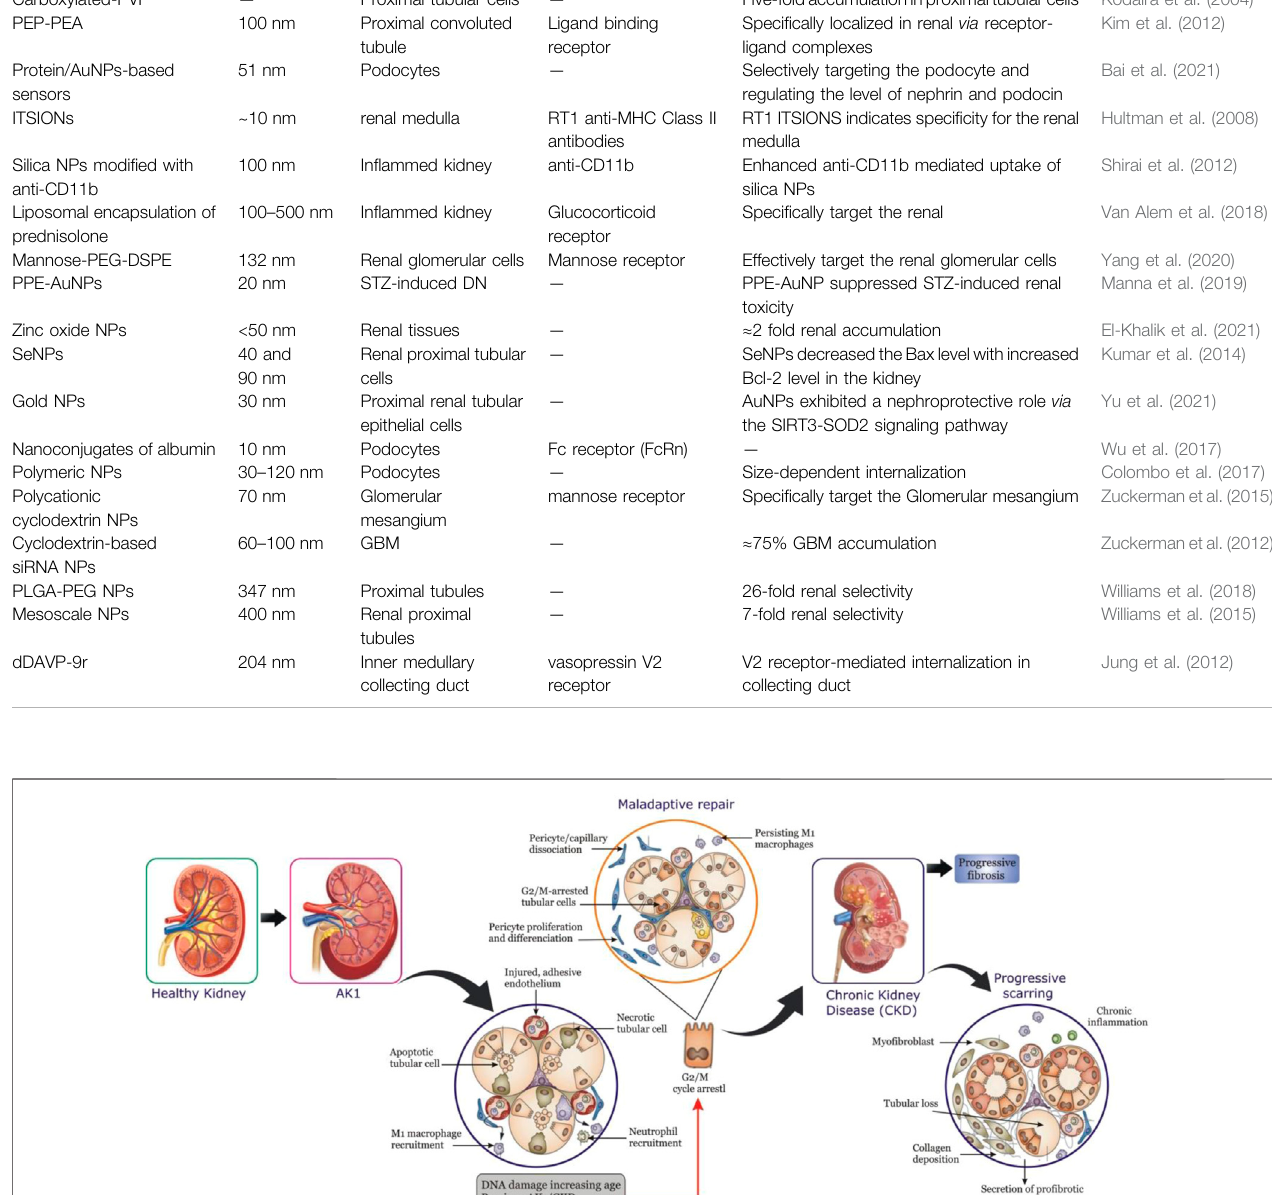
Frontiers in Bioengineering and Biotechnology |